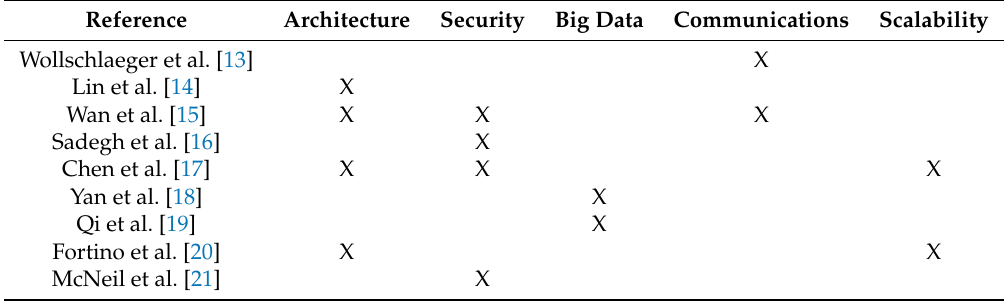
Table 1. Related work